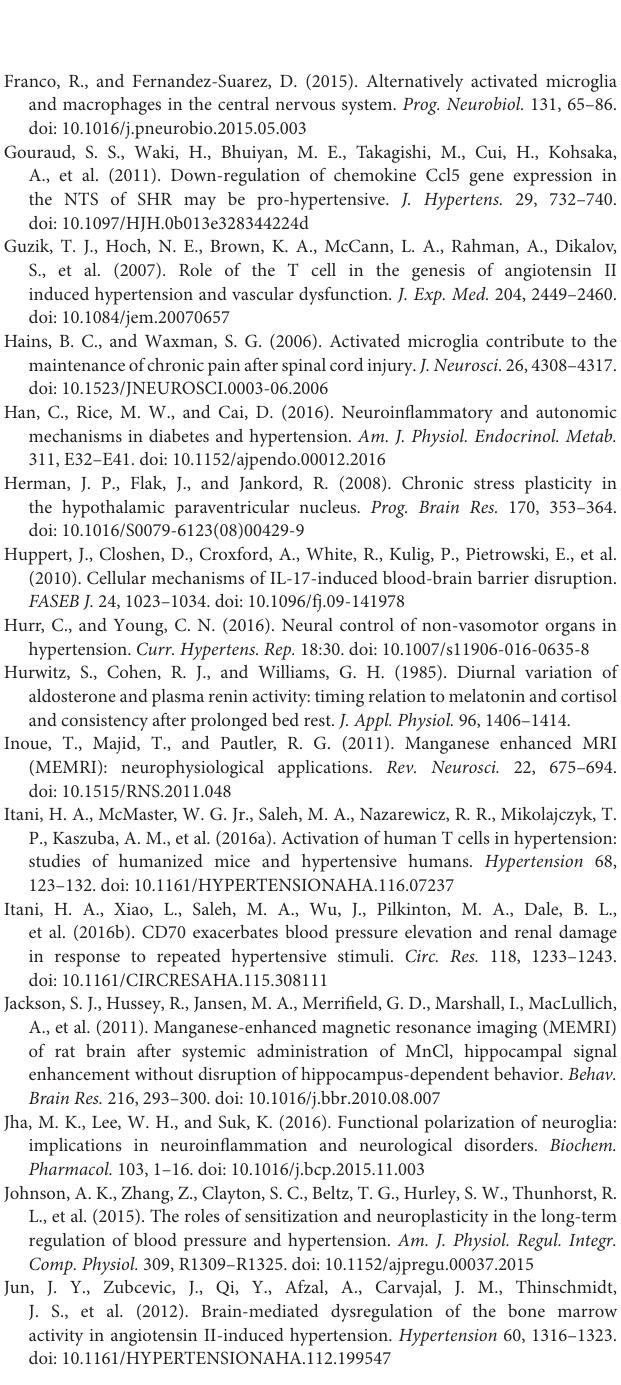
Figure S3 | Changes in the manganese-labeled activation of several cardioregulatory brain regions following a single systemic injection of Ang II (red bars). N = 6, ∗ P < 0.05. AHA, anterior hypothalamic area; cAN, central amygdaloid nucleus; dMN, dorsal medial nucleus; dRN, dorsal raphe; lAN, lateral amygdaloid nucleus; LC, locus ceruleus; LHN, lateral hypothalamus; mAN, medial amygdaloid nucleus; mRN, median raphe nucleus; PN, parabrachial nucleus; PHA, posterior hypothalamic area; RL, raphe linear; SNC, substantia nigra compacta; SON, supraoptic nucleus; SCN, sub coeruleus nucleus; VS, ventral